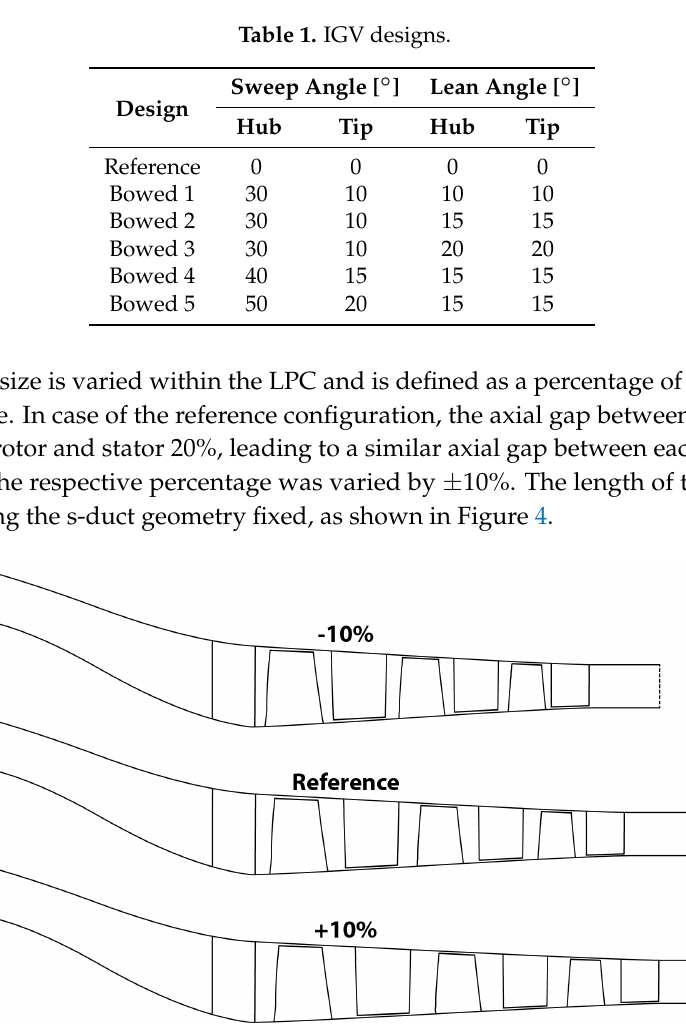
Figure 4. LPC with different axial gap